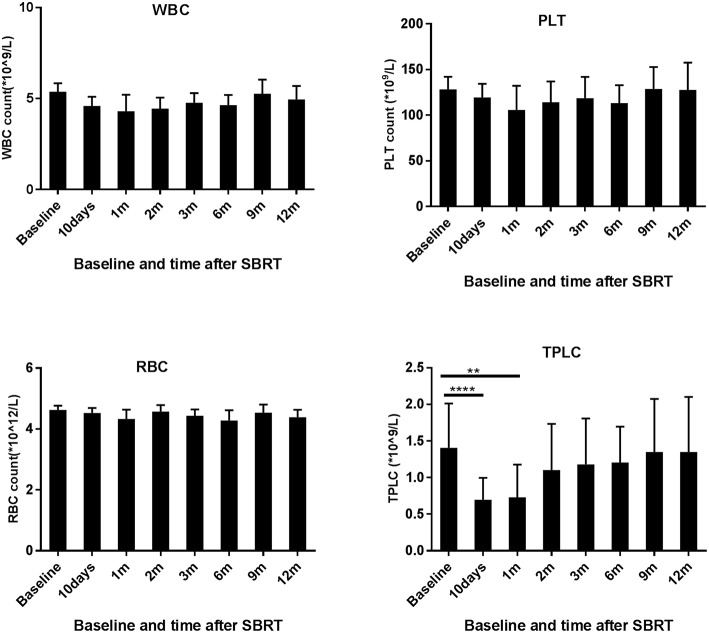
Effects of stereotactic body radiation therapy (SBRT) on peripheral blood cells in 78 patients with hepatocellular carcinoma. The counts of white blood cells (WBCs), red blood cells (RBCs), and platelets (PLTs) and total peripheral lymphocyte count (TPLC) were calculated at baseline (within 3 days prior to SBRT) and at different time points since SBRT (10 days and 1, 2, 3, 6, 9, and 12 months) as indicated for patients with HCC. **Significantly different at p < 0.01 compared to the baseline values. ****Significantly different at p < 0.0001 compared to the baseline values.